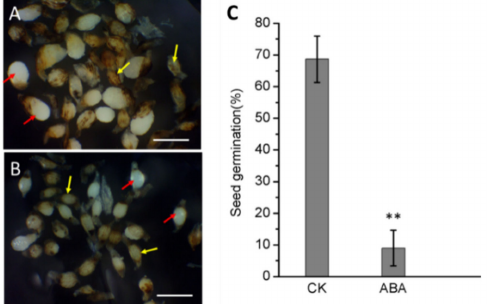
Figure 5. E ff ect of exogenous ABA on asymbiotic germination of immature seeds of P. armeniacum . The seeds harvested at 94 DAP were used to represent immature seeds’ germination performance. Light microscope images of ( A ) the germinated immature seeds without any treatment and the immature seeds treated with 5 µ g / mL ABA ( B ) in the culture medium. The immature seeds with exogenous ABA treatment demonstrated a reduced ability on both embryo swollen and seed coat rupture, as compared to the one without ABA treatment. Red arrow: Embryo that have breakthrough seed coat; Yellow arrow: Embryo that have not broken through the seed coat. Scale bar = 1 mm. ( C ) Asymbiotic germination rate of the CK (control) and ABA-treated immature seeds. n = 3; ± SD; Asterisks indicate significant di ff erence from the WT (Student’s t test, p <